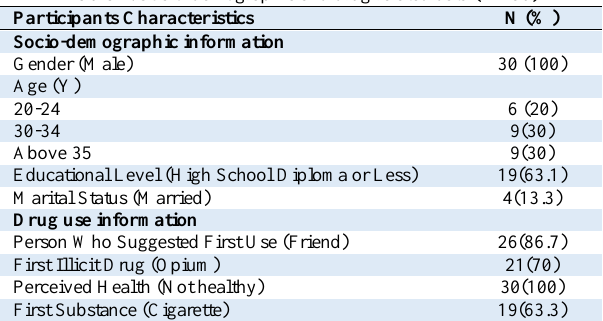
Table 1. Socio-demographic and drug related data (n = 30) Participants Characteristics